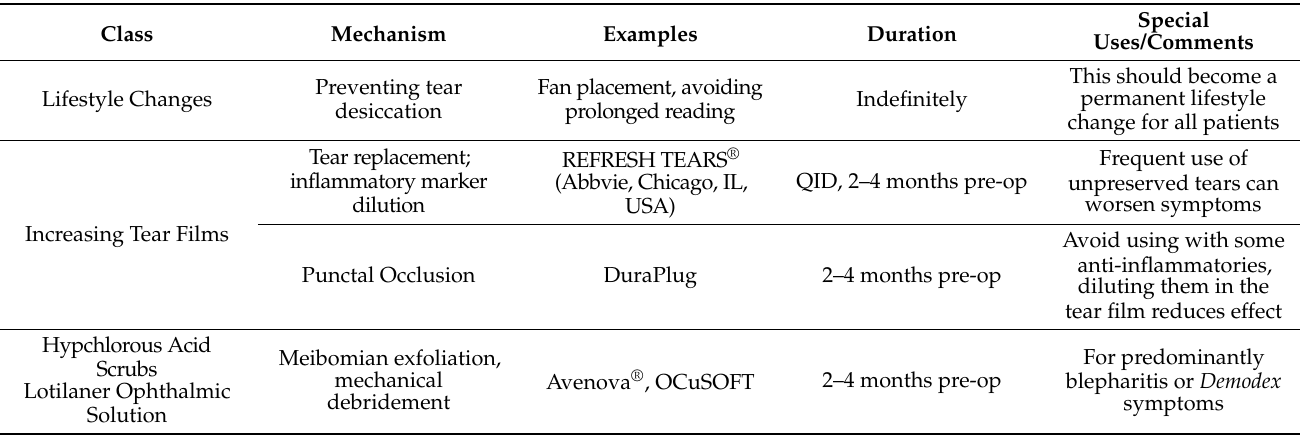
Table 2. Strategies, Mechanisms, and Option of Various Treatments for Ocular Surface Optimization and Surgical Temporary Ocular Discomfort Syndrome